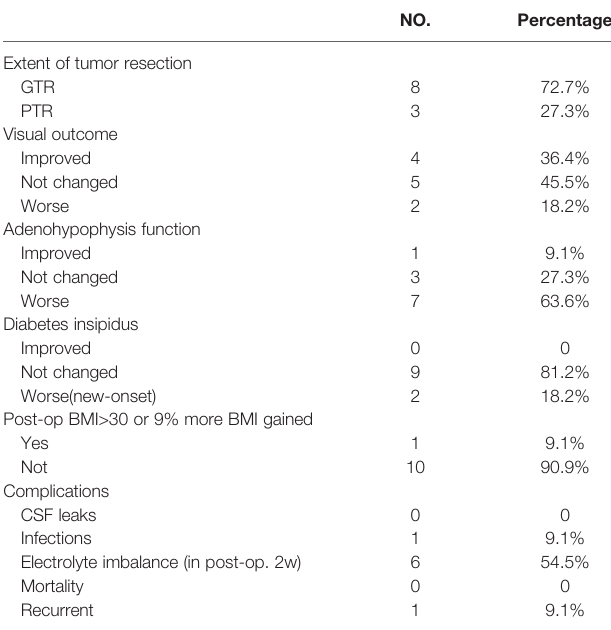
TABLE 2 | Clinical outcomes of 11 patients with tumor resection by TLTA.